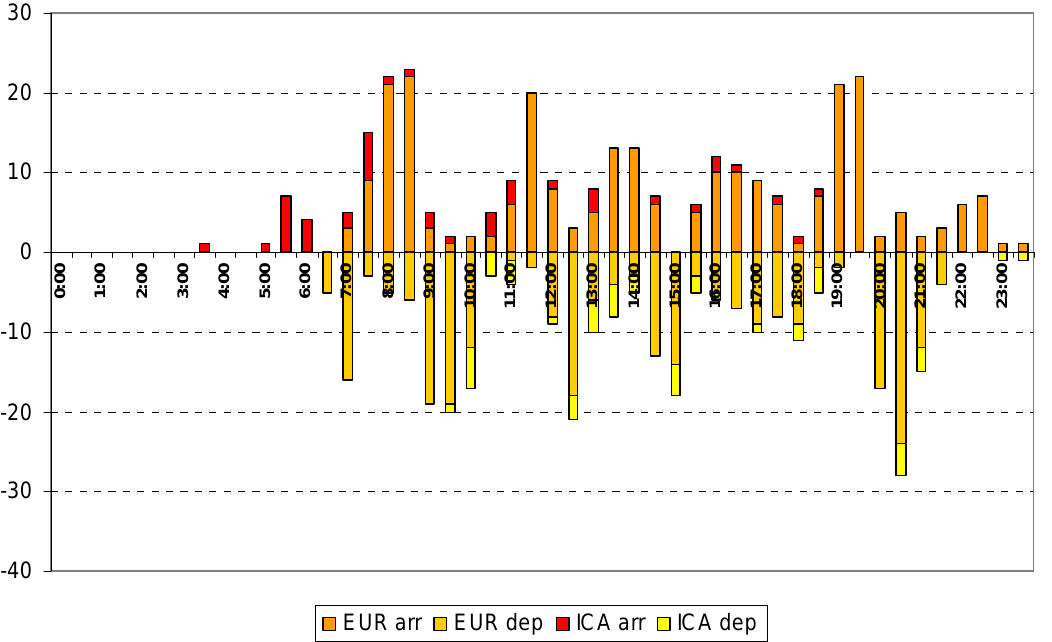
Figure 1. European and intercontinental movements of KLM per half hour at Amsterdam (OAG, 20-09-2006, local time) Source: OAG